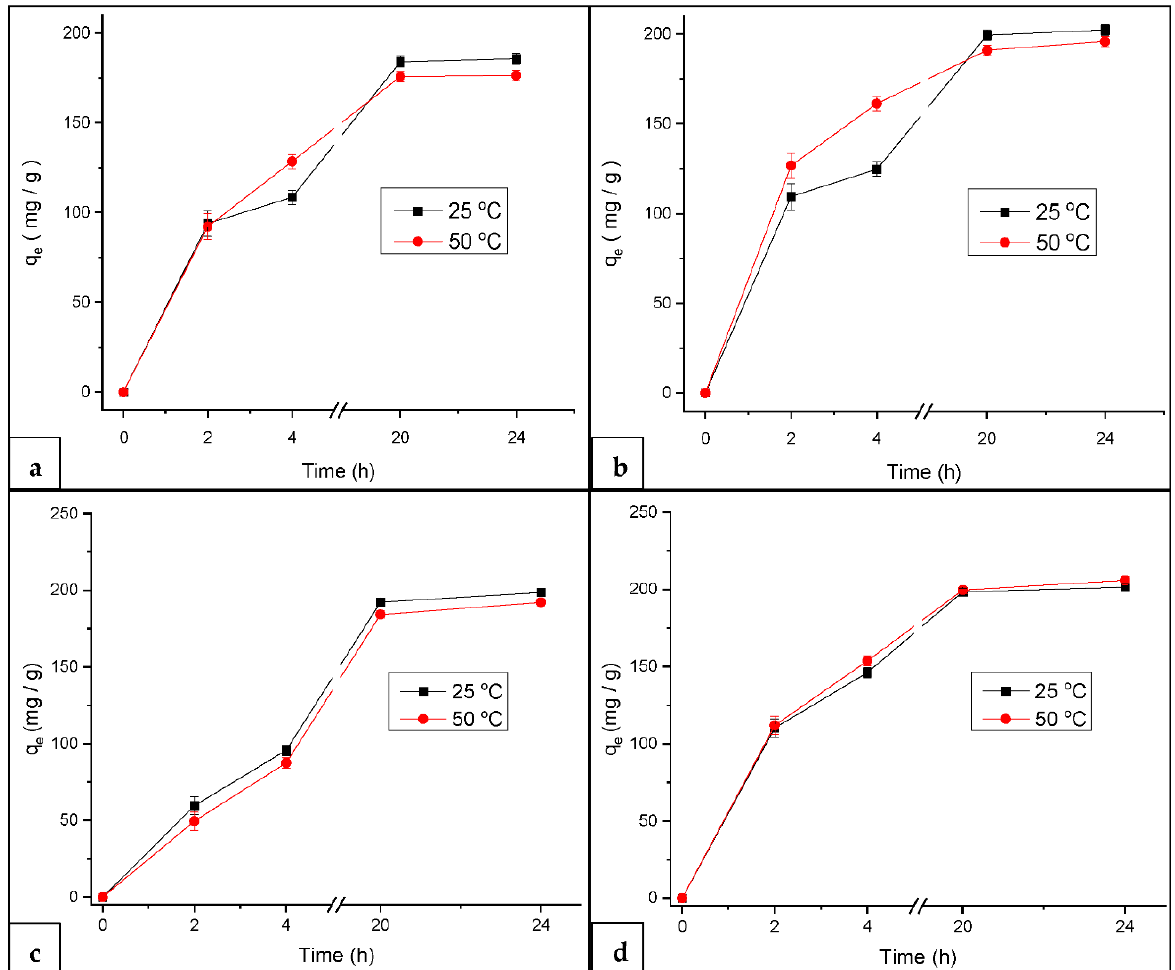
Figure 7. MB adsorption capacity as a function of time at ( a ) pH 4.0 and ( b ) pH 8.0 using SAP and at ( c ) pH 4.0 and ( d ) pH 8.0 using SAP-AC as adsorbent. ( c ) pH 4.0 and ( d ) pH 8.0 using SAP-AC as At pH 4.0, the observed MB adsorption capacity was 185.74 mg g − 1 at 25 °C and 176.44 mg g − 1 at 50 °C, respectively. In comparison, at pH 8.0, a higher MB adsorption